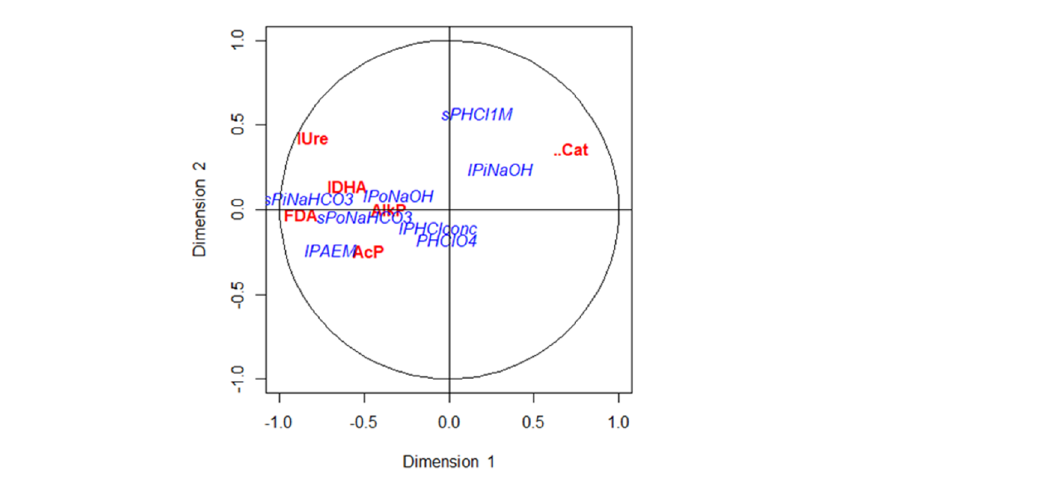
Figure 7. Variables plot for the first canonical dimension of the Canonical Correlation Analysis performed to the P fractions and the soil enzymatic activity parameters. Abbreviations for soil parameters as in Table S2.